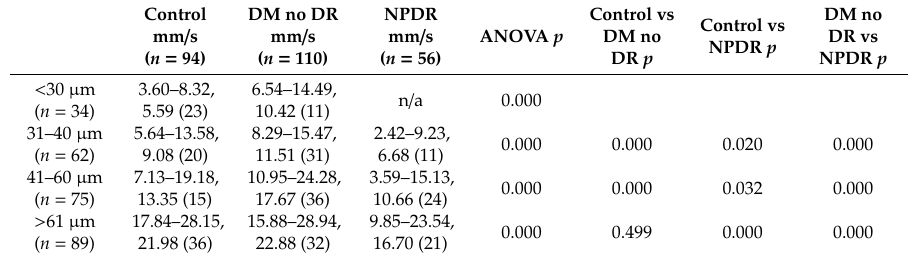
Table 2. Summary of blood velocity in arterioles and venules by vessel diameter groups, comparing healthy controls, diabetes without retinopathy, and non-proliferative diabetic retinopathy.